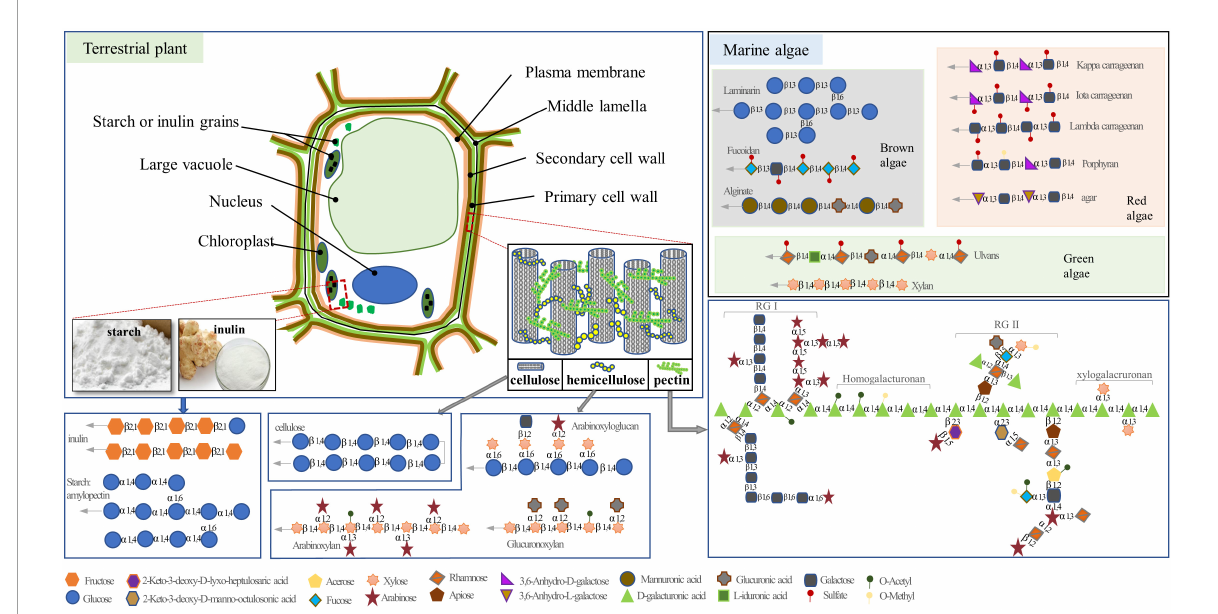
FIGURE1 The structure of polysaccharides in plant and marine algae. The gray arrows indicate the possibility of extended polymer